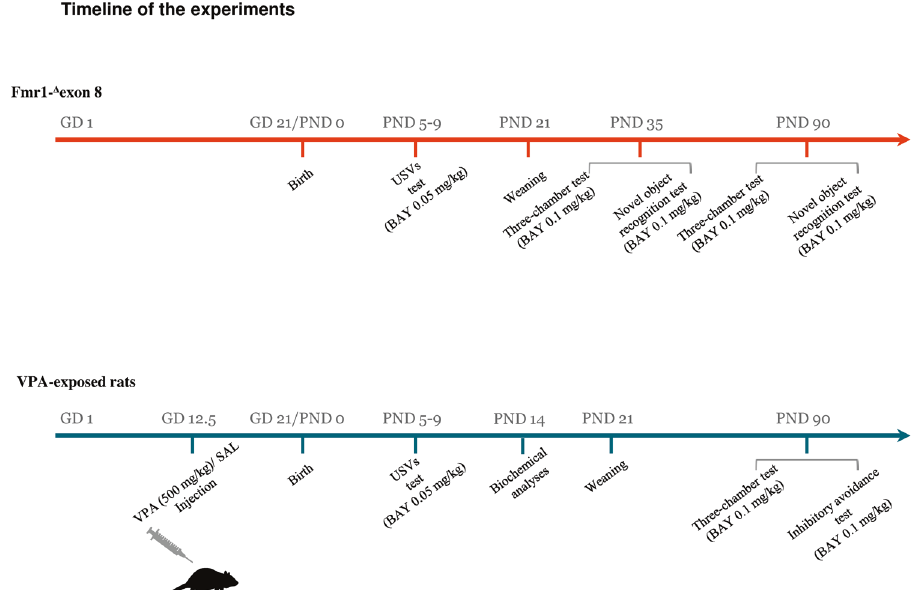
Fig. 1 Timeline of the experiments. Sequence of the behavioral and biochemical experiments performed in the two rat models of